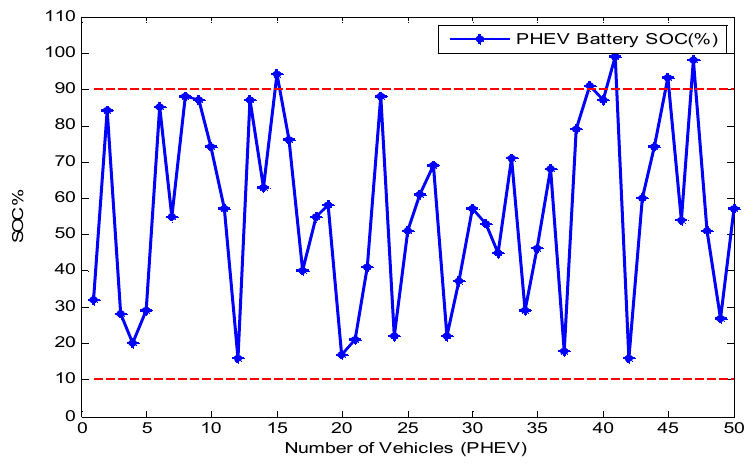
Figure 10. Battery SOC of various vehicles.